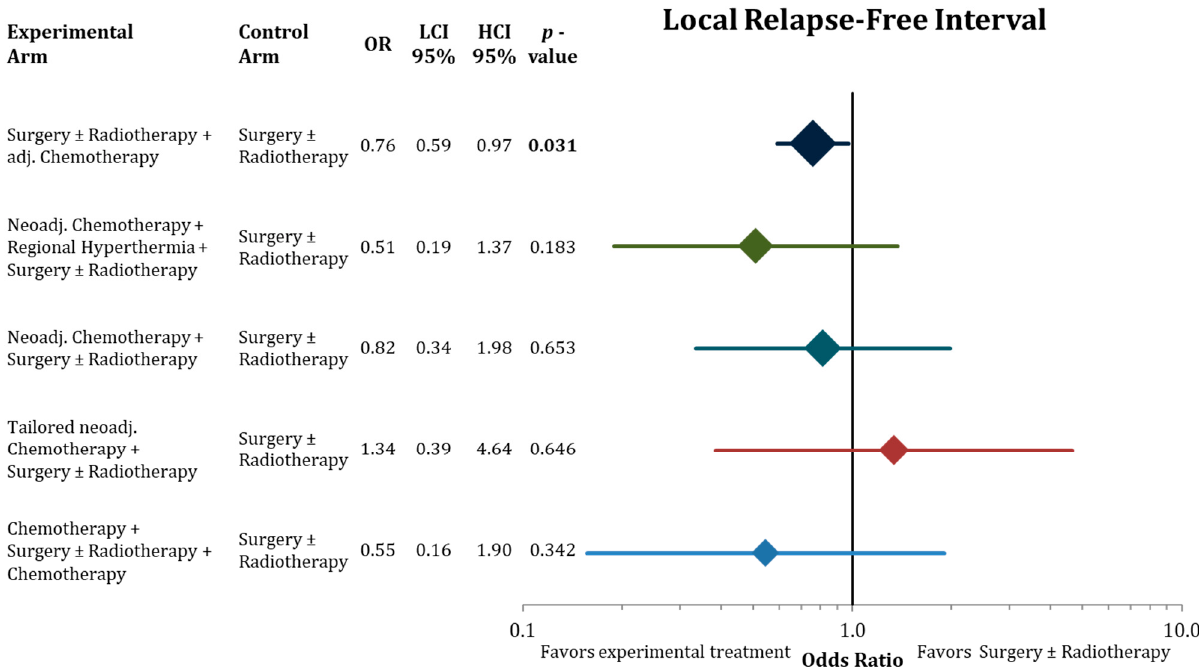
Figure 4. Forest plot comparing disease-free survival in the network analysis of the experimental treatments against sur- gery ± radiation therapy. Hazard ratios with 95% confidence intervals and the corresponding p -values are presented. The sizes of the diamonds are proportional to the weights in the meta-analysis. HR = hazard ratio, LCI = lower limit of 95% confidence interval, and HCI = higher limit of 95% confidence interval. Bold values indicate significant p -values.